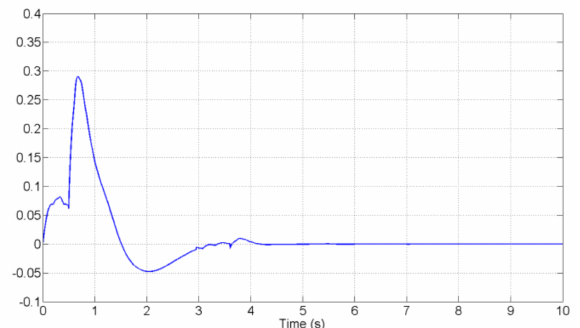
Figure 5. Output observer-based control trajectory.